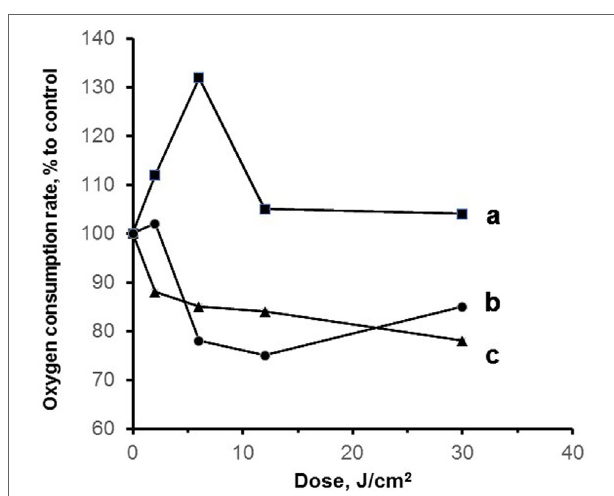
FigURe 6 | Mitochondria respiration in experimental endotoxic shock [reproduced with the permission of Springer Publisher from Buravlev et al. (26)]. The experimental model of endotoxic shock was produced by intraperitoneal injection of 40 mg/kg lipopolysaccharide B from Escherichia coli 0111:B4 (Sigma-Aldrich). Rat liver mitochondria (1.0 mg protein/ml) were isolated and kept on ice in storage buffer (buffer content see in the legend